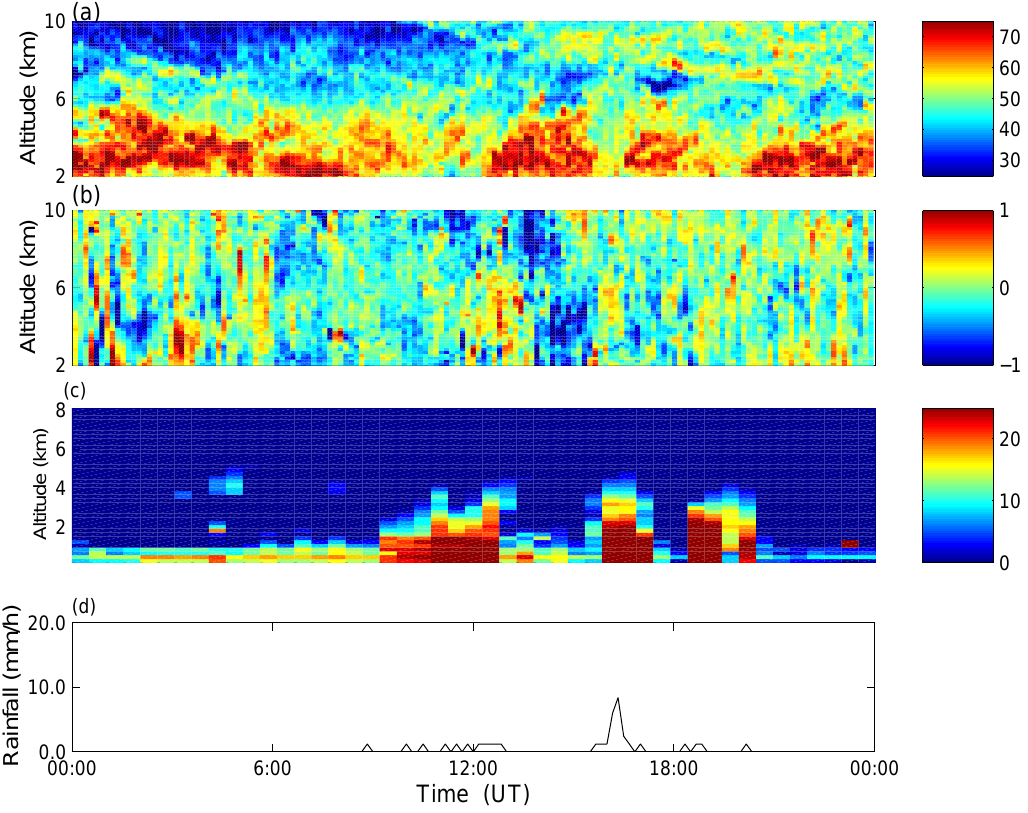
Fig. 3. Time-height contour plots of ( a ) vertical signal power (dB), ( b ) vertical velocity (m s − 1 ) observed by the VHF radar, ( c ) the vertical signal-to-noise ratio measured by a co-located UHF wind profiler (dB) and ( d ) the variation of surface rainfall observed by a tipping bucket rain gauge on 22 January